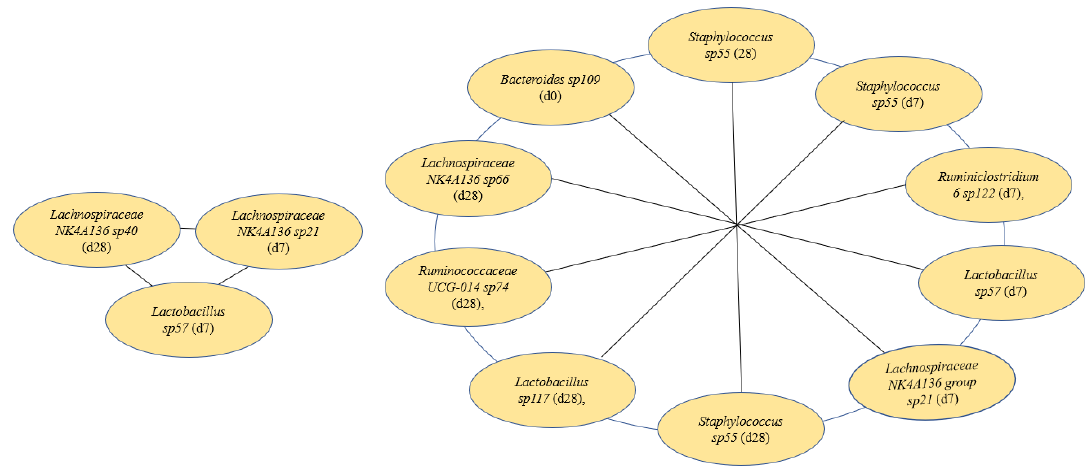
Figure 6. Short ( left ) and long ( right ) signatures detected by machine learning, d = day.